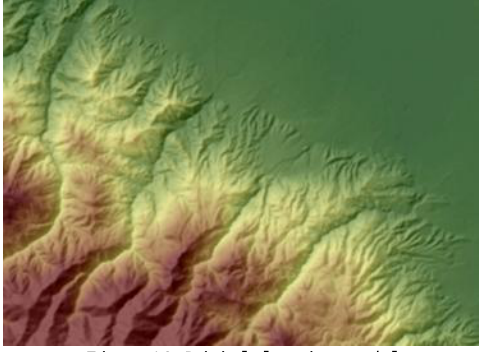
Figure 12. Digital elevation model This is a leading indicator of spatial data base together with the need for precise elevation model is created. (Figure 12).